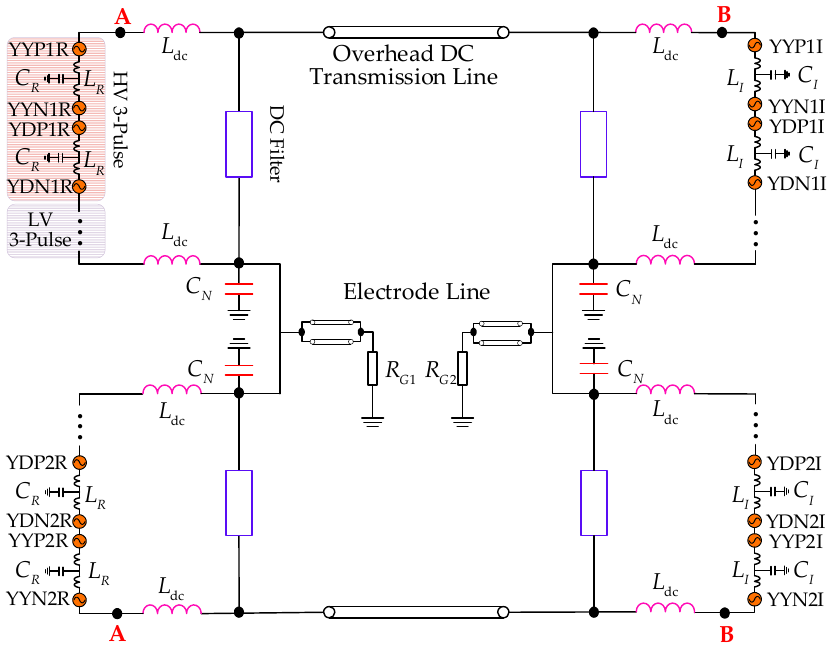
Figure 5. Equivalent DC-side harmonic analysis model.